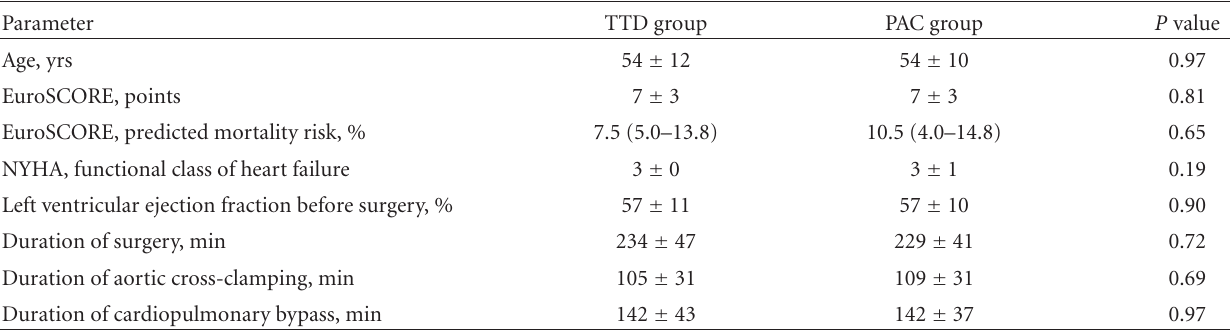
Table 1: Pre- and intraoperative characteristics of the study